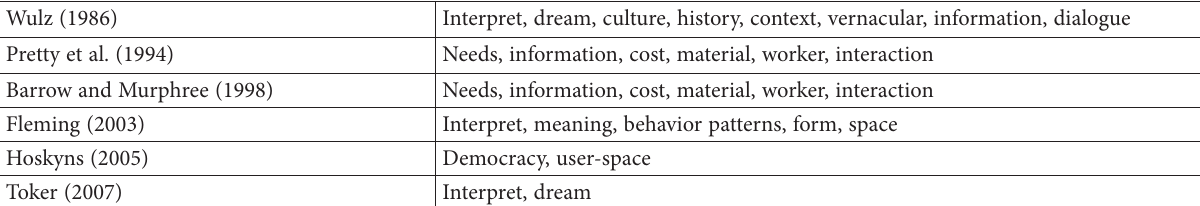
Table 7. Key codes related to community and participatory